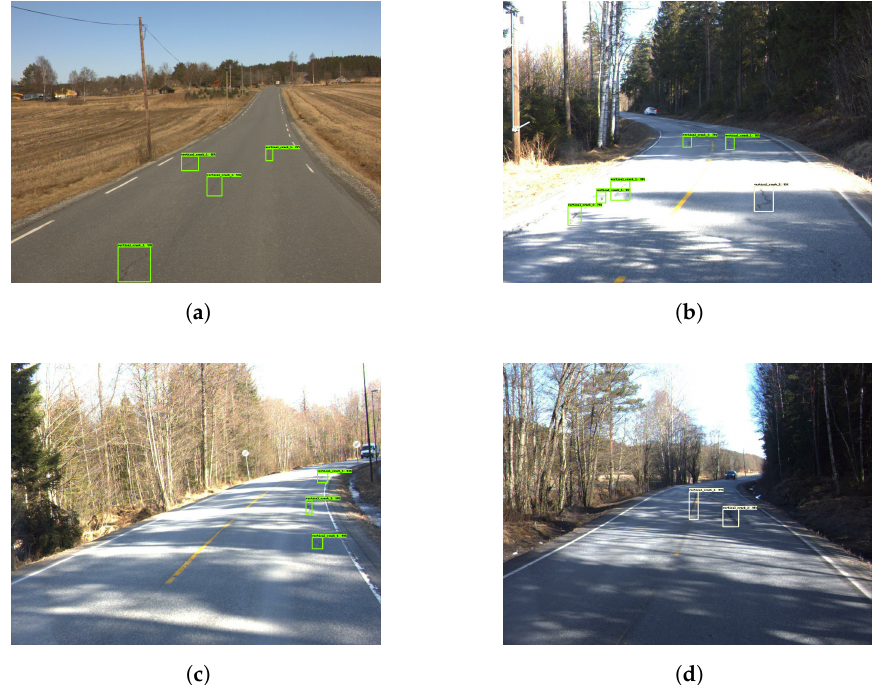
Figure 12. Good damage detection—Model 3. The green and yellow boxes represent the vertical cracks.